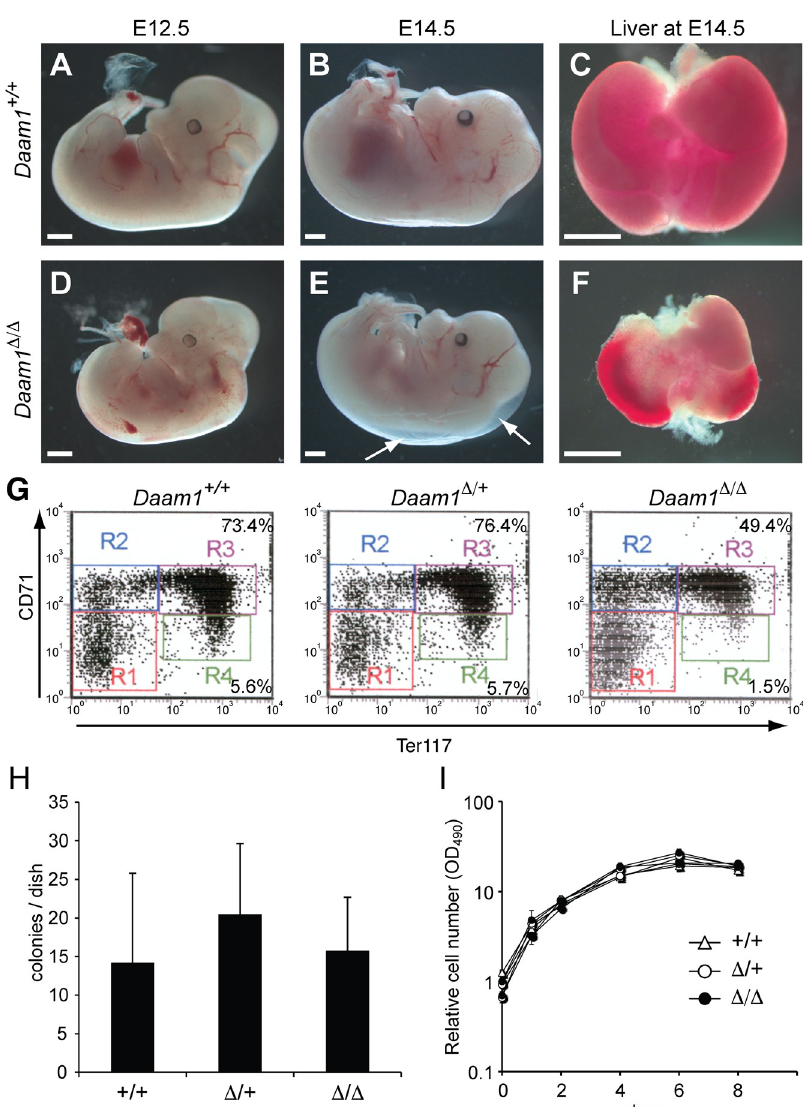
Fig 1. Observation of Daam1 -deficient embryos. (A-E) Daam1 +/+ (A-C) and Daam1 Δ / Δ (D-F) embryos at E12.5 (A, D), E14.5 (B, E) and livers at E14.5 (C, F). Edema found in Daam1 Δ / Δ embryo is indicated by arrows (E). (G) Representative results of fetal liver-derived erythrocyte differentiation analyzed by flow cytometry. Percentages of the cells gated in R3 and R4 were as follows: Daam1 +/+ : R3 (CD71 hi ;Ter119 hi ) = 76.5 ± 2.4%, R4 (CD71 lo ;Ter119 hi ) = 6.4 ± 0.8%; n = 5, Daam1 Δ /+ R3 = 73.8 ± 6.8%, R4 = 6.3 ± 1.7%; n = 4, and Daam Δ / Δ :R3 = 64.2 ± 9.0%, R4 = 3.3 ± 1.6%; n = 5. Daam1 Δ / Δ erythrocytes were significantly reduced compared with Daam1 +/+ and Daam1 Δ /+ : t-test R3 p < 0.01, R4 p < 0.002. (H) BFU-E colony formation assay using fetal liver cells. Daam1 +/+ : n = 5, Daam1 Δ /+ : n = 5, and Daam1 Δ / Δ : n = 4. Standard deviations are shown as error bars. No significant difference was observed. (I) MEFs proliferation assay. Relative cell numbers were measured by MTS assay. Results were normalized by day 0 as 1. Results represent analyses of 5 or more embryos of each genotype. No significant difference was observed.